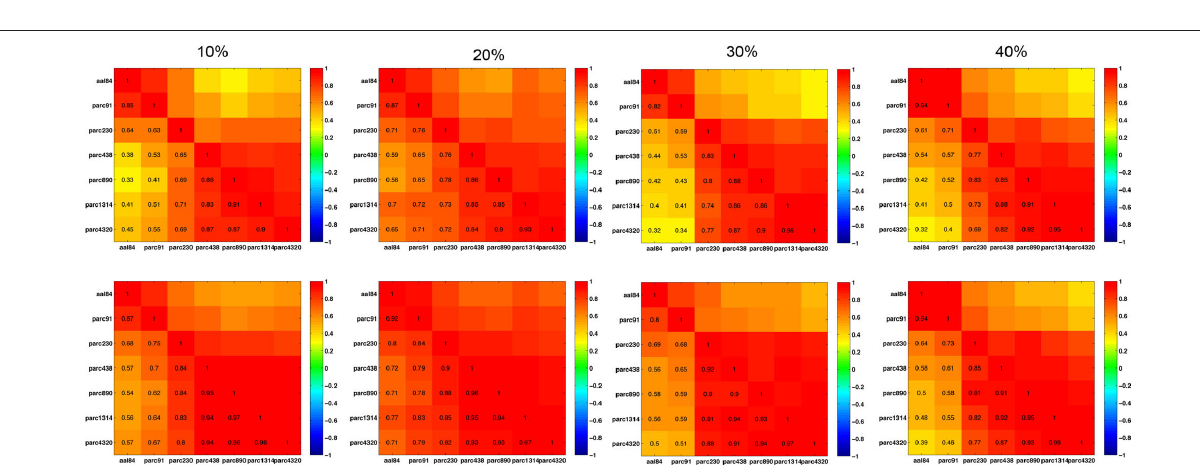
FIguRe 11 | Inter-scale correlations in degree distribution power-law exponents (top row) and exponential cut-off values (bottom row) for costs of 10, 20, 30, and 40% (left to right